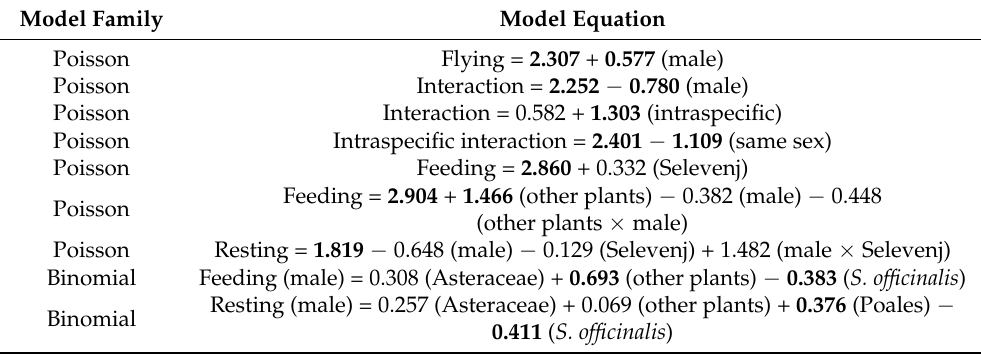
Table 1. Summary of the Poisson models comparing average time spent on individual behaviours during the butterfly tracking study and binomial models comparing intersexual differences in plant preferences during the mark–release–recapture study. Model Family Model Equation Poisson Flying = 2.307 + 0.577 (male) Poisson Interaction = 2.252 − 0.780 (male) Poisson Interaction = 0.582 + 1.303 (intraspecific) Poisson Intraspecific interaction = 2.401 − 1.109 (same sex) Poisson Feeding = 2.860 + 0.332 (Selevenj) Feeding = 2.904 + 1.466 (other plants) − 0.382 (male) − 0.448 Poisson (other plants × male)